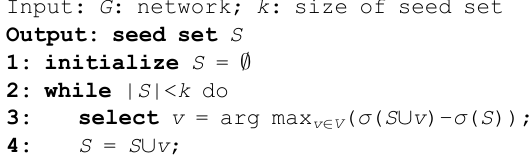
Algorithm 1 Greedy ( G , σ TSSCM ( S ), k )